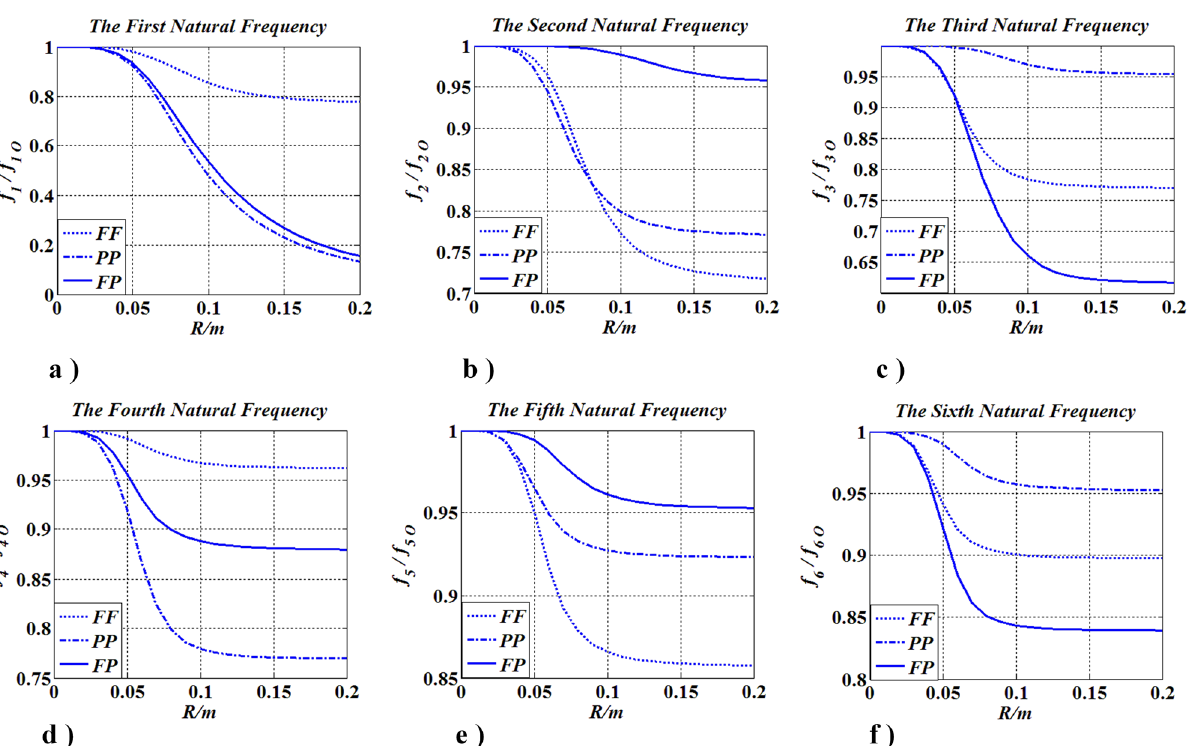
Figure 19. Frequencies change with R ( J m ) and boundary